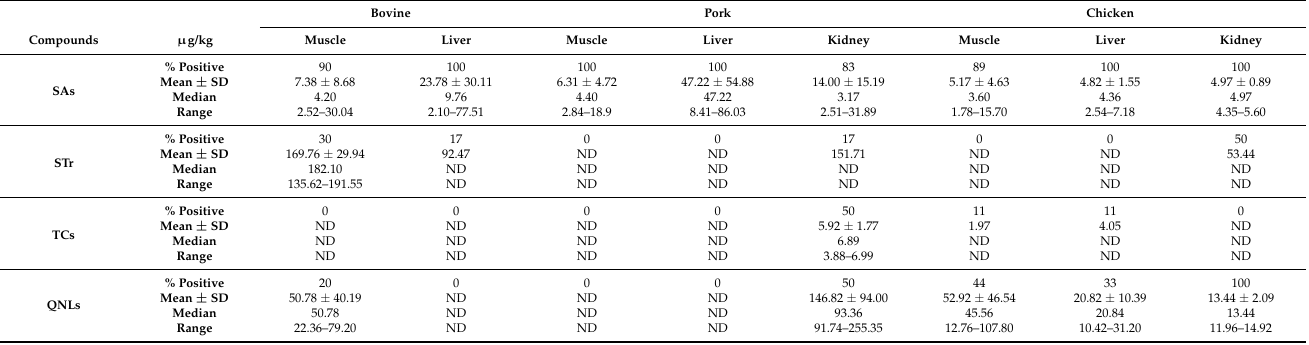
Table 4. Monitoring results (in µ g/kg) of antibiotics in all meat samples by ELISA